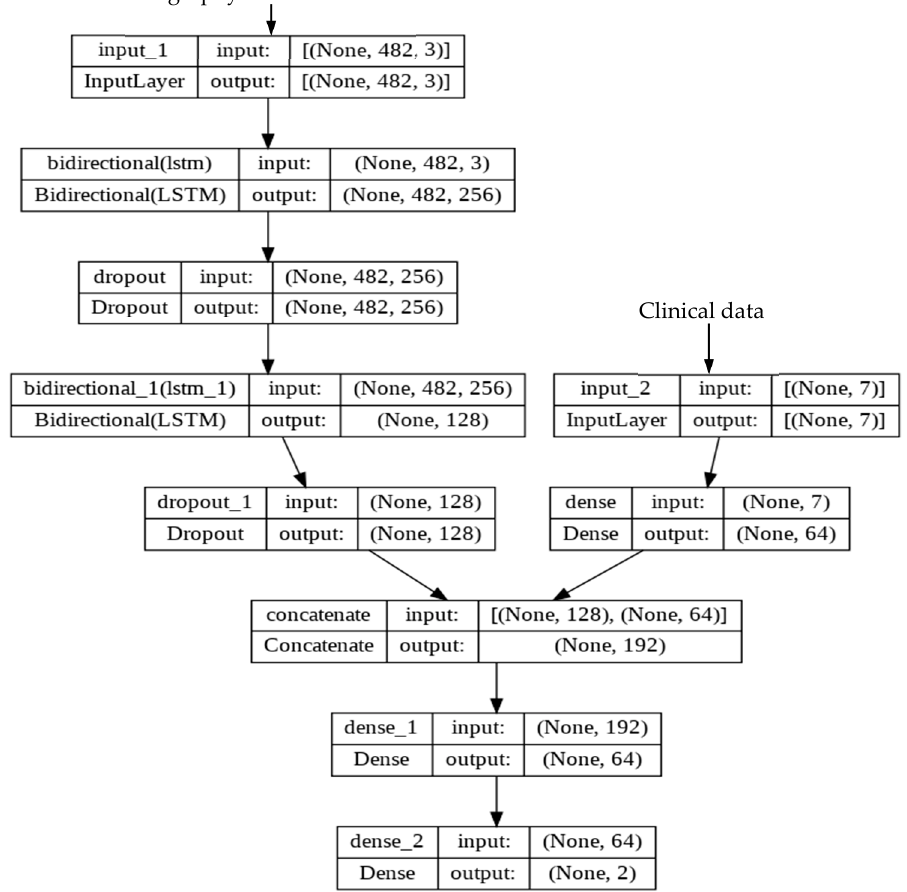
Figure A6. Configuration of BiLSTM model used for experiment with time series data and clinical data.